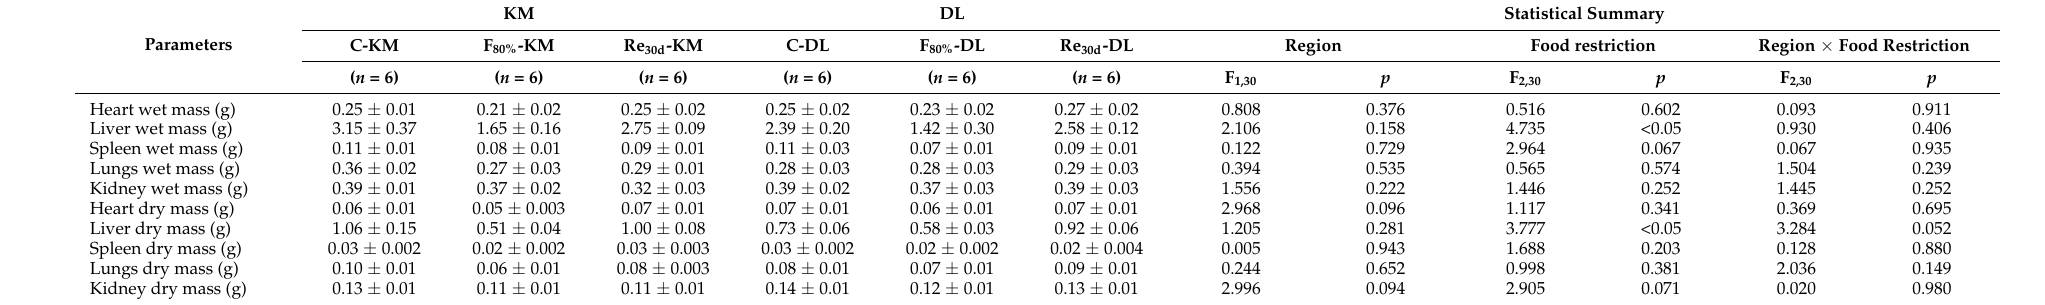
Table 4. Body composition of E. miletus in different regions under food restriction.